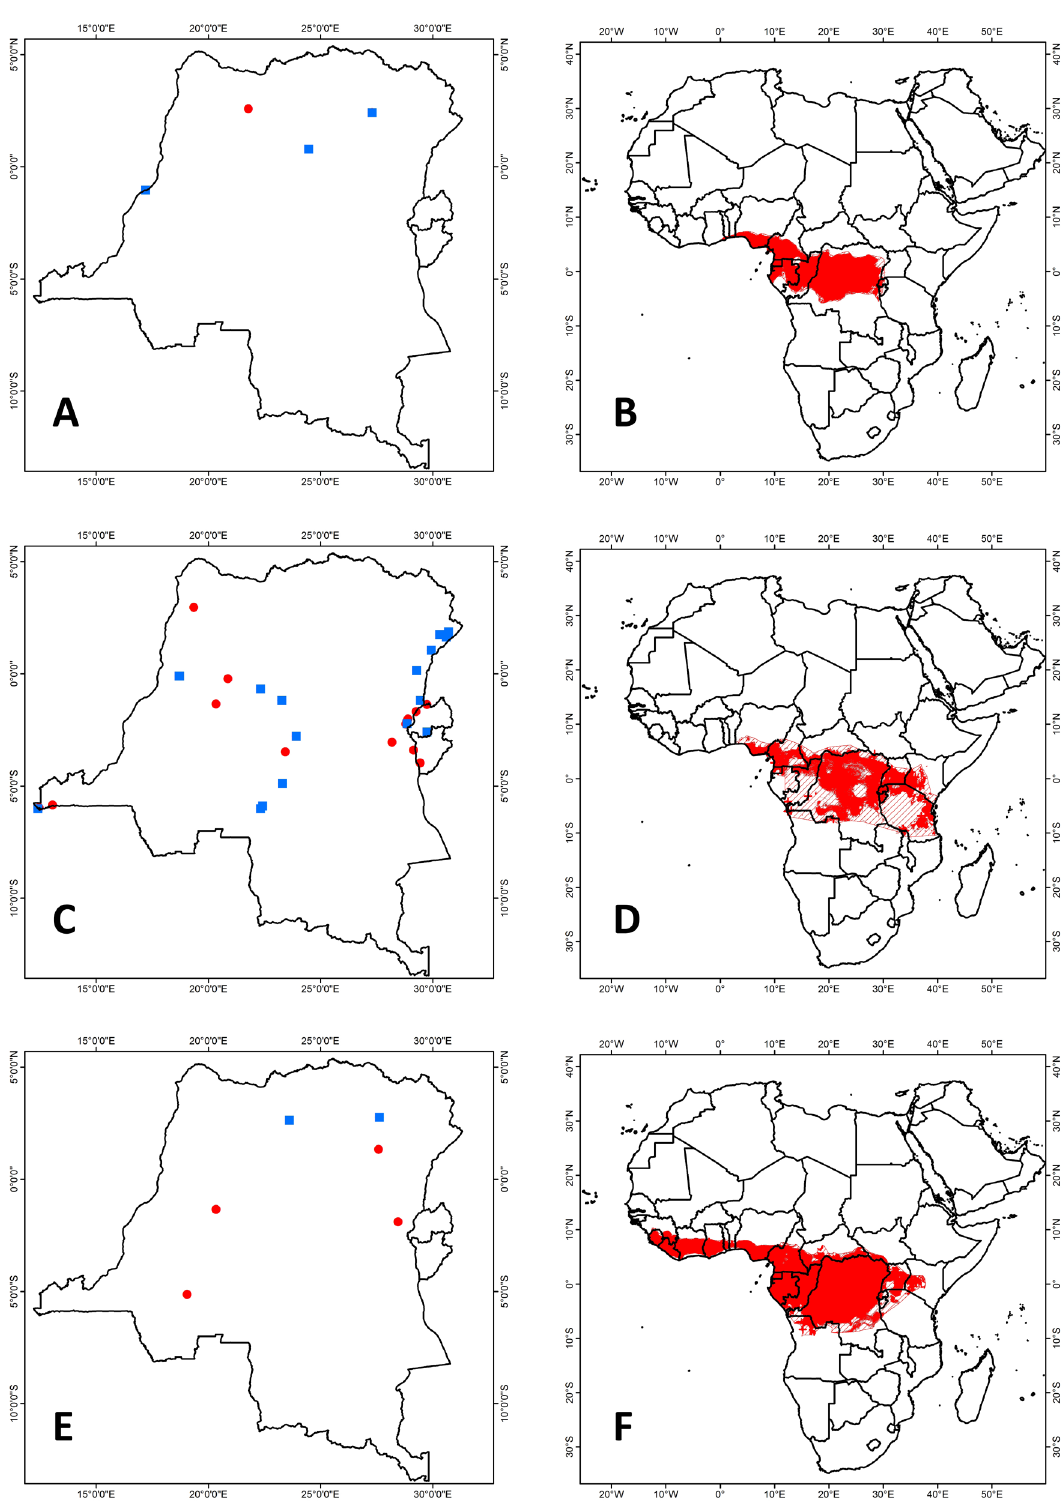
Fig. 38. Distribution maps. A–B . Glauconycteris alboguttata J.A. Allen, 1917. C–D . Glauconycteris argentata (Dobson, 1875). E–F . Glauconycteris beatrix Thomas, 1901. A, C, E. Distribution in the